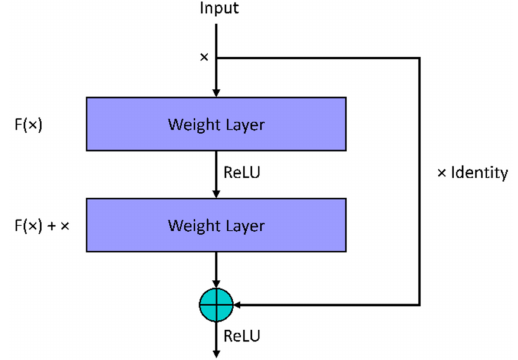
Figure 3. Building block of a residual network.